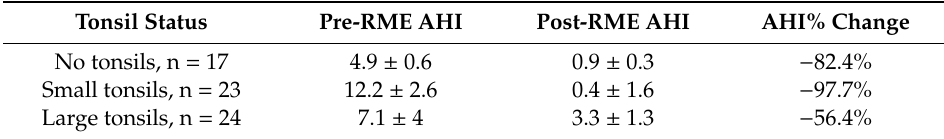
Table 5. Pre and Post RME Outcomes Based on Prior Adenotonsillectomy and Tonsil